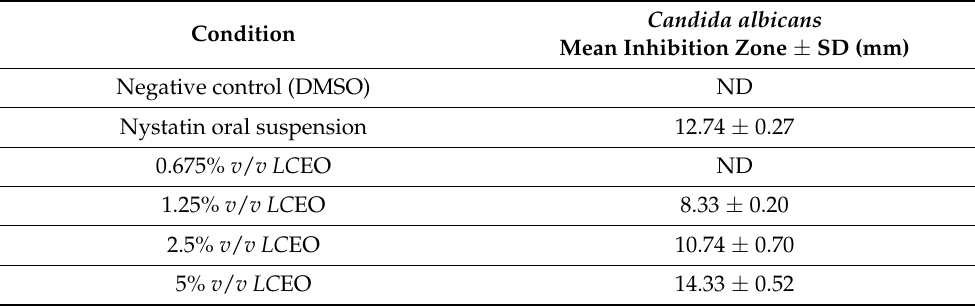
Table 2. Mean inhibition zone ± SD ( n = 5) of different concentrations of LC EO against C. albicans. Inhibition zone less than 6 mm was defined as not detected